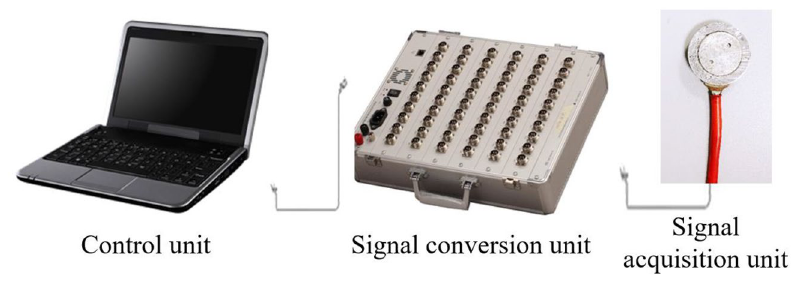
Figure 4. Static strain test system.